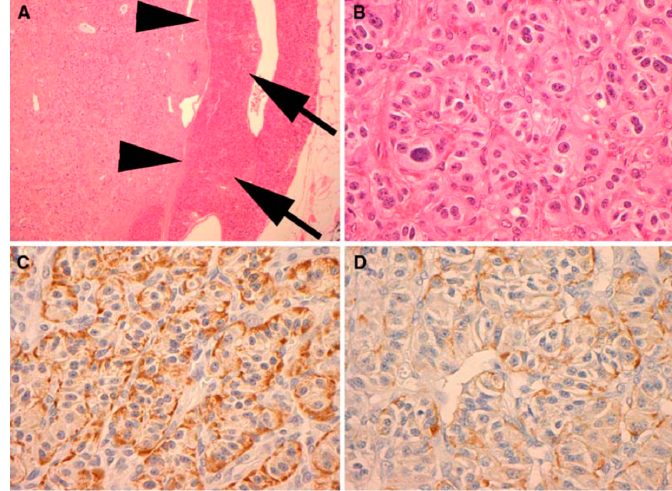
Figure 3. Immunohistochemical (IHC) analysis to PP (Novocastra NCL-PPp, dilution 1/500) ( A ). All PPomas were not encapsulated but well circumscribed and separated from the adjacent normal pancreas (arrows) by a smooth pseudocapsule (arrowheads) ( B ). All PPomas exhibit characteristic features typical of neuroendocrine differentiation, including speckled chromatin (“salt and pepper”) and a nested and trabecular architecture. Original H & E 600× amplification ( C ). All PPomas show